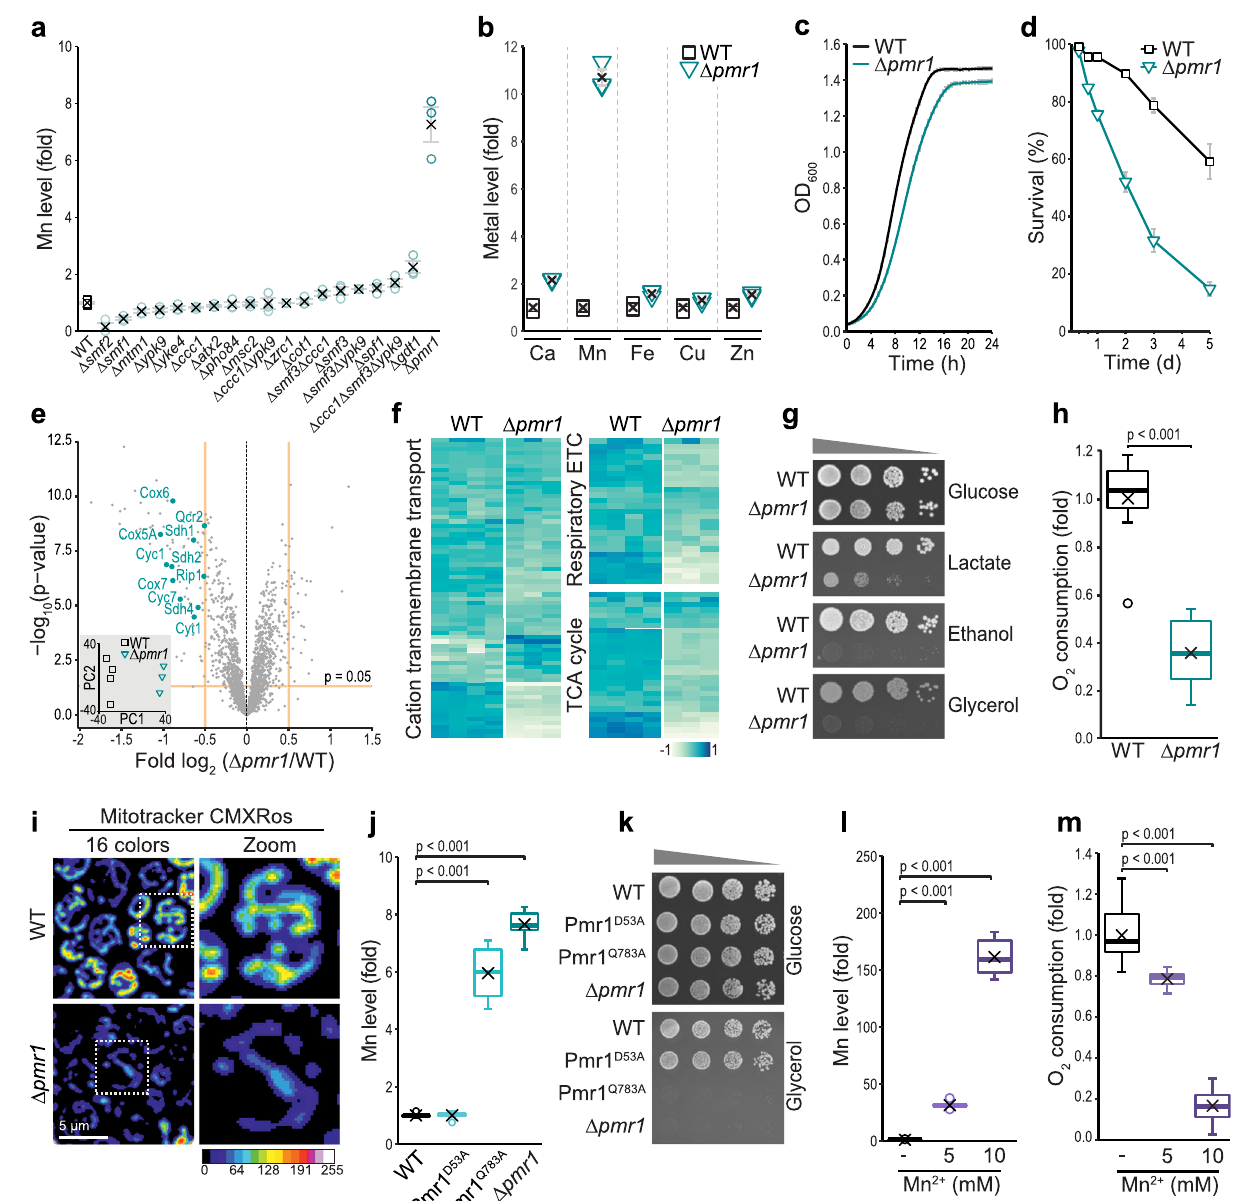
Fig. 1 | Cellular Mn overload disrupts mitochondrial bioenergetics. a , b Total cellularMn( a )and metal( b )contentof wild type(WT)cellsand indicatedmutants determined via Total re fl ection X-Ray Fluorescence (TXRF) spectrometry. Cells were collected after 24h of growth on glucose. Means±SEM; ( a ) n =6 (WT) or 3 (mutants). ( b) n =3. c Growth kinetics of WT and Δ pmr1 cells grown as described ( a , b ).Means±SEM, n =8. d Survivaldeterminedby fl ow cytometric quanti fi cation ofpropidiumiodidestainingofWTand Δ pmr1 cellsatindicatedtimepointsduring aging. Means±SEM, n =8(8h and 120h) or n =12 (16, 24, 48, and 72h). e, f Whole- cellproteomics of WT and Δ pmr1 cells grownasdescribedin( a , b ). n =4 (WT)or 3 ( Δ pmr1 ). e Volcano plot displaying results of differential protein abundance ana- lysis(DeqMS).Signi fi cantlylessormoreabundantproteinsofGOterm ‘ Respiratory electron transport chain ’ are labeled. Inset: Scatterplot of principal component analysis. f Heatmaps of identi fi ed proteins associated with indicated GO